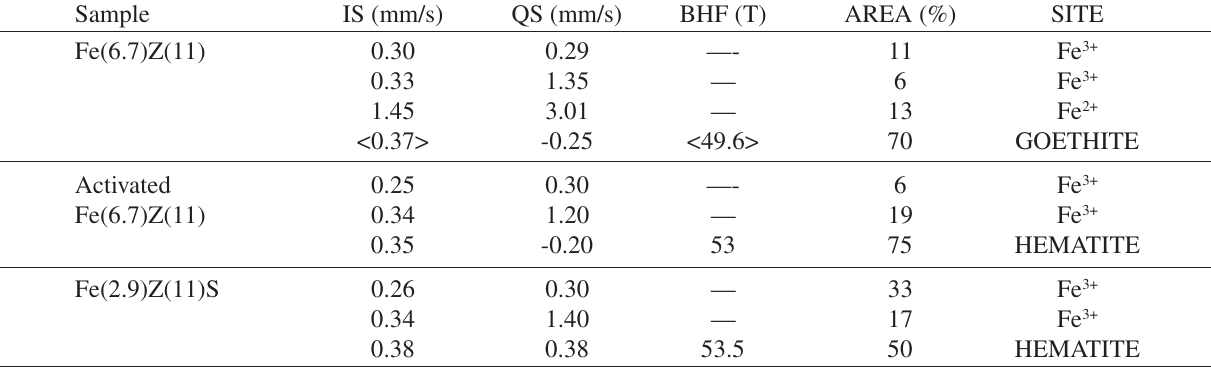
Table 3. Mössbauer spectroscopy data obtained from Fe/ZSM-5 zeolites at -269 °C.